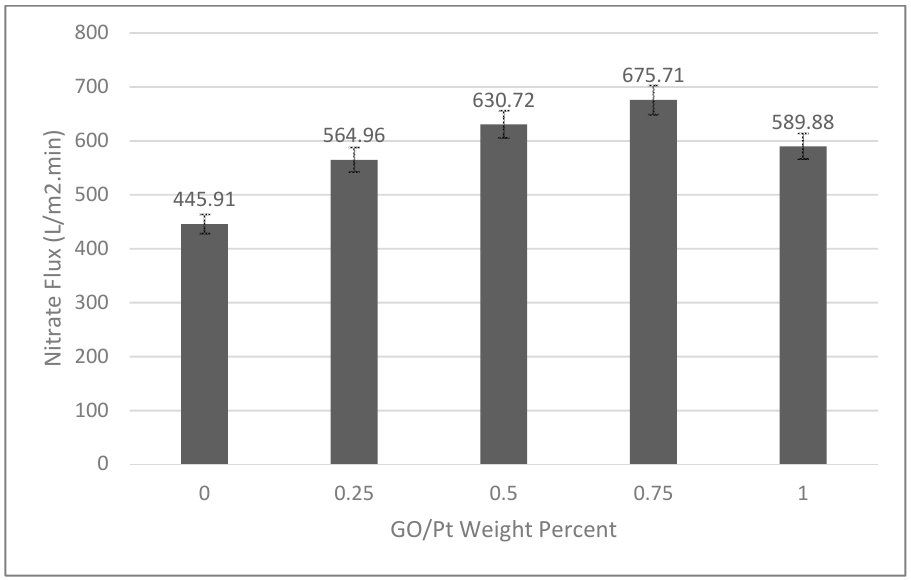
Figure 6. Nitrate flux of prepared polysulfone membranes under different loading percentage of GO/Pt nanoparticles.